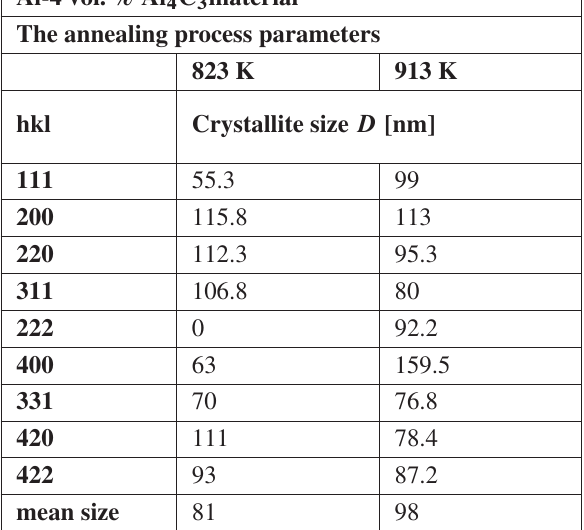
Table 1. The size of crystallites of Al-4 vol. % Al 4 C 3 com- posite annealed at 823 K and 913 K for 100